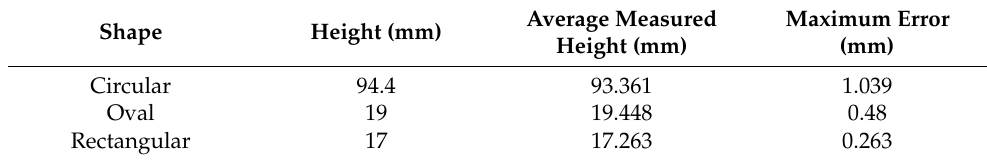
Table 4. Maximum average error for height determination.